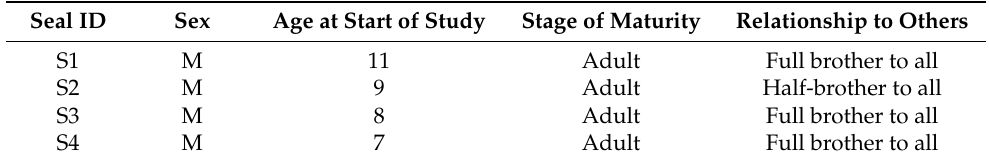
Table 1. South American fur seals at Bristol Zoo Gardens.